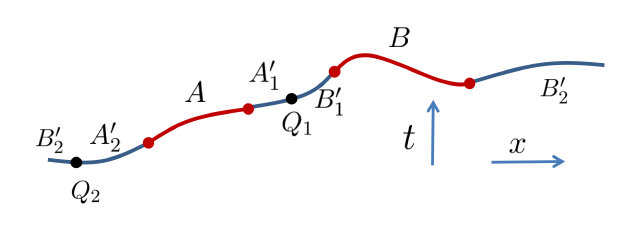
with gravitational 2 , Q into four 1 2